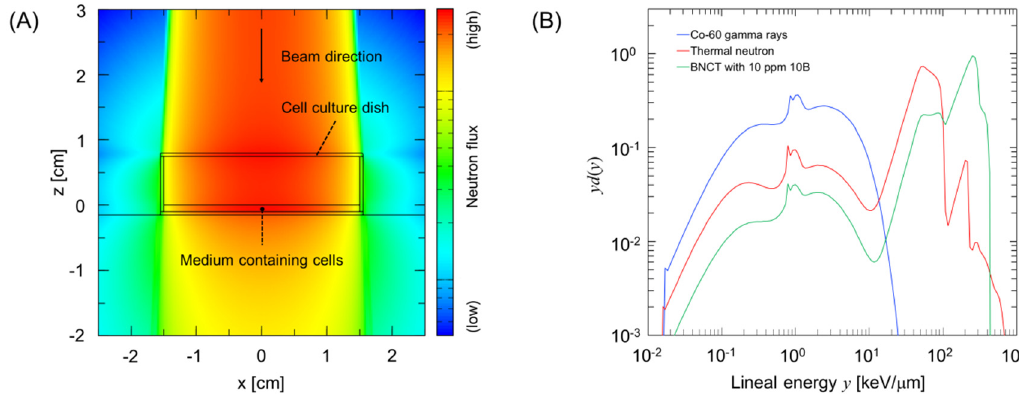
Figure 2. Calculation of the microdosimetric quantities of y D and y * for thermal neutrons and boron neutron capture therapy (BNCT) irradiations. ( A ) shows the simulation geometry illustrated by the Particle and Heavy Ion Transport code System (PHITS) code [28], and ( B ) shows examples of relationships between lineal energy y and probability density of dose d ( y ) in a domain with a diameter of 1 µ m for calculating y D and y *. These values were used to calculate cell-survival probability using the integrated microdosimetric-kinetic (IMK) model.